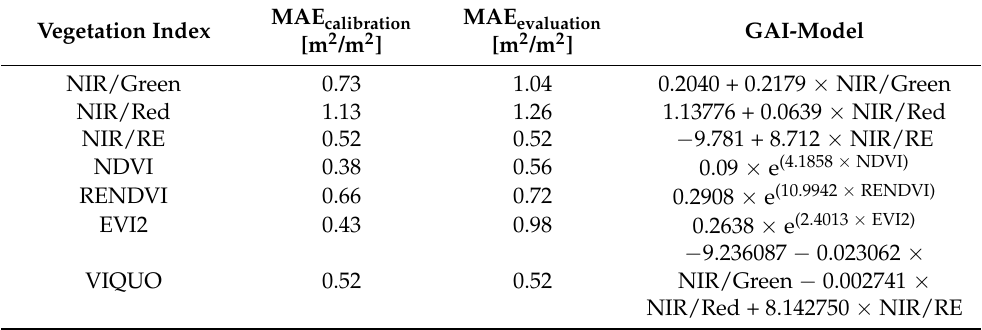
Table 3. Models for GAI-prediction with Sentinel-2 data and their Mean Absolute Errors (MAE) in calibration and evaluation.